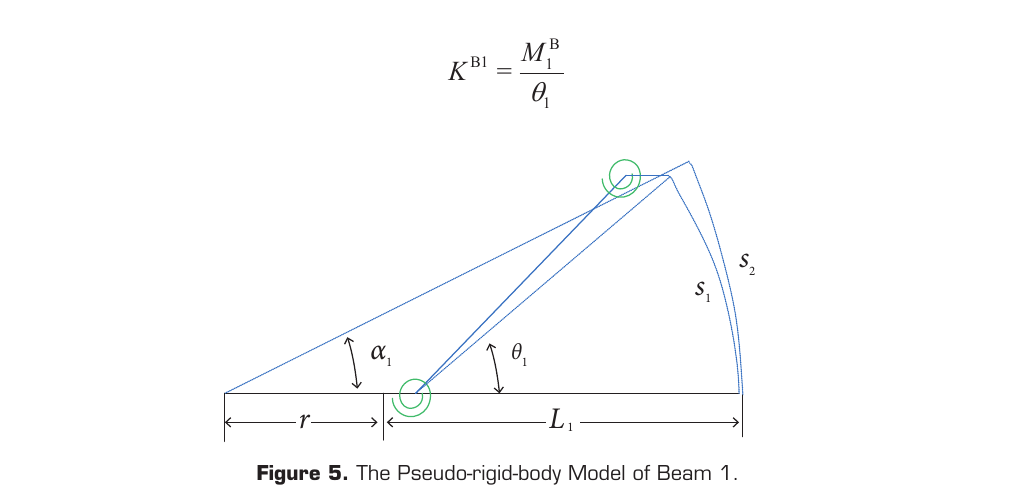
Figure 5. The Pseudo-rigid-body Model of Beam 1.